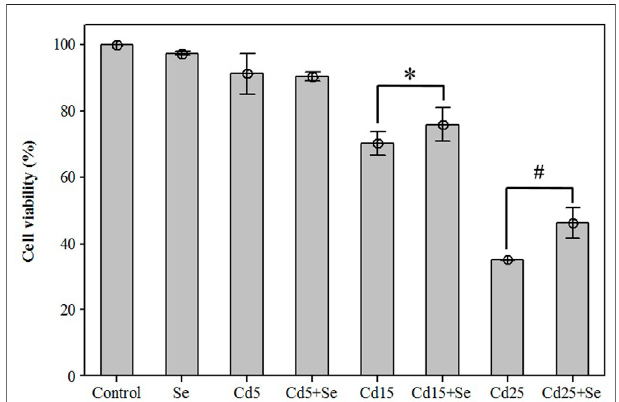
FIGURE 2 | Effects of different concentrations of CdCl 2 and/in combination with SeMet on cell viability in HepG2 cells. Values are expressed as mean ± S.D. ( n = 3) (*): signi fi cant differences between groups Cd15 and Cd15+Se; (#): signi fi cant differences between groups Cd25 and